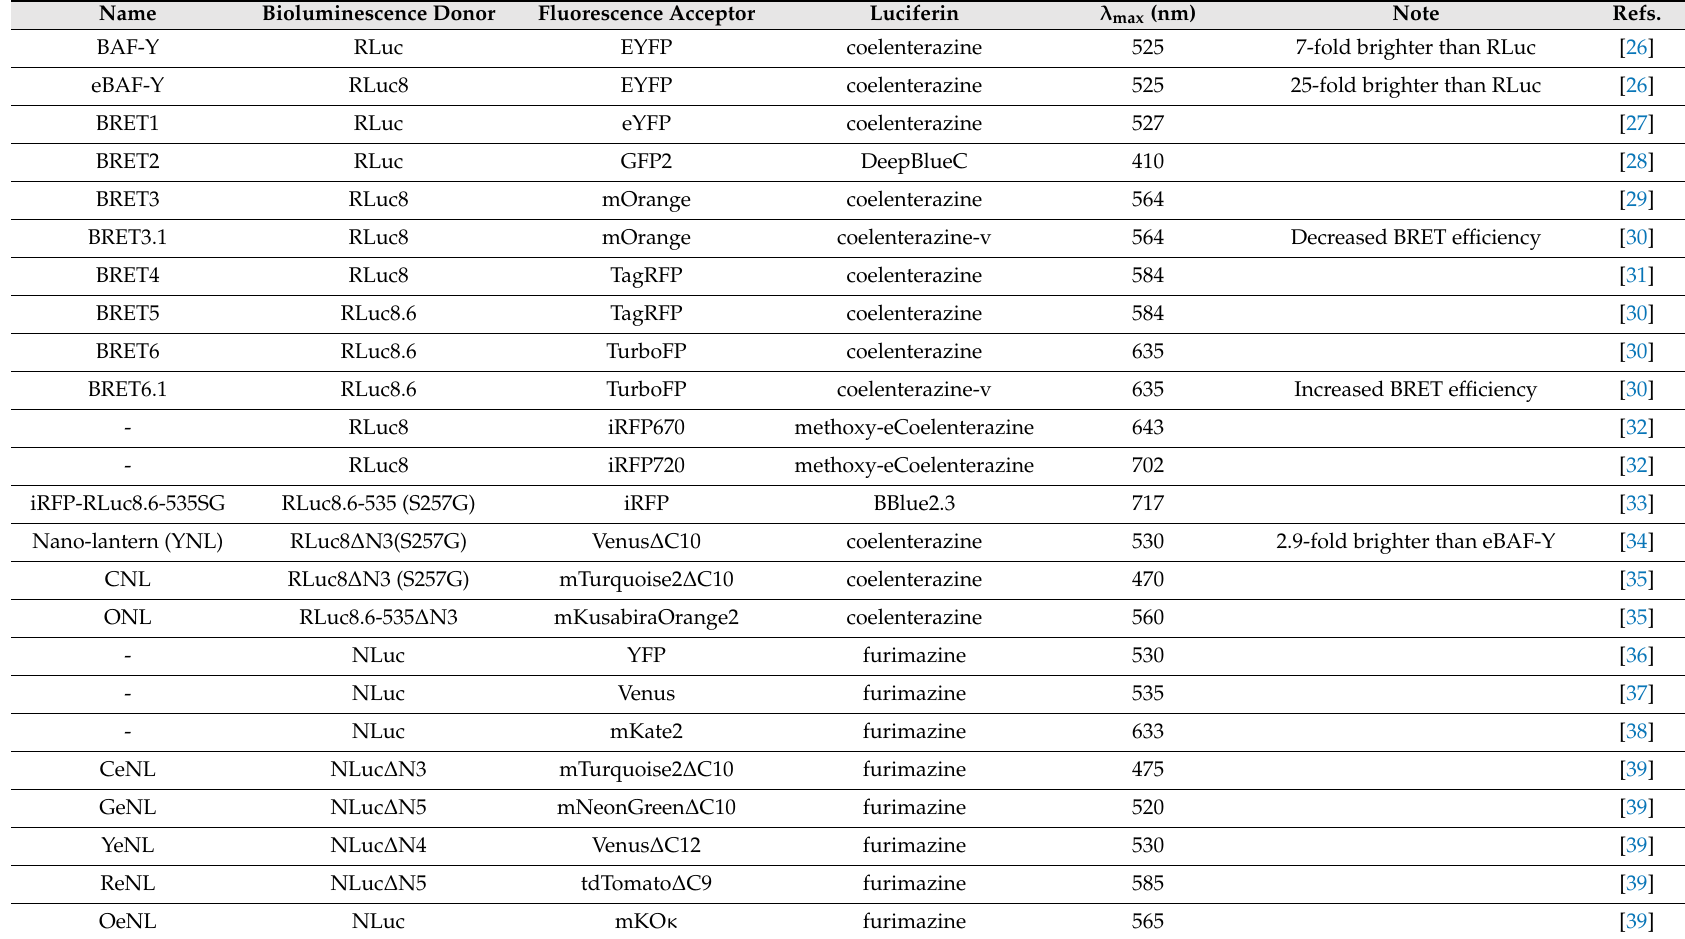
Table 2. The BRET-based bioluminescence